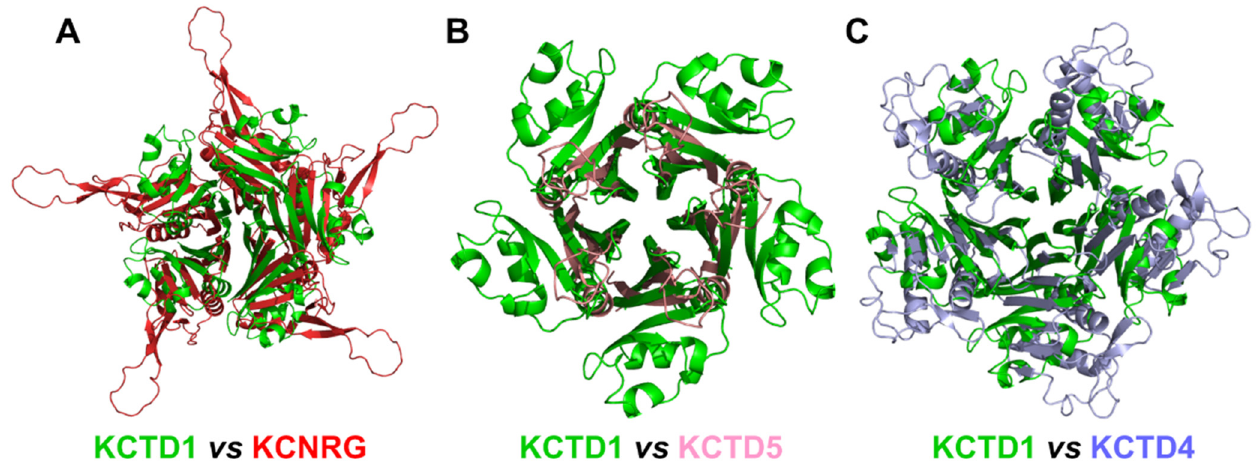
Figure 9. Structural alignment of the CTDs of KCTD1 (green) with ( A ) KCNRG (red), RMSD of 25.07 Å, 417 C α atoms aligned; ( B ) KCTD5 (pink), RMSD of 8.14 Å, 188 C α atoms aligned; ( C ) KCTD4 (light blue), RMSD of 12.73 Å, 314 C α atoms aligned. The structural superimpositions were obtained by combining US-align and PyMOL (see Section 4).